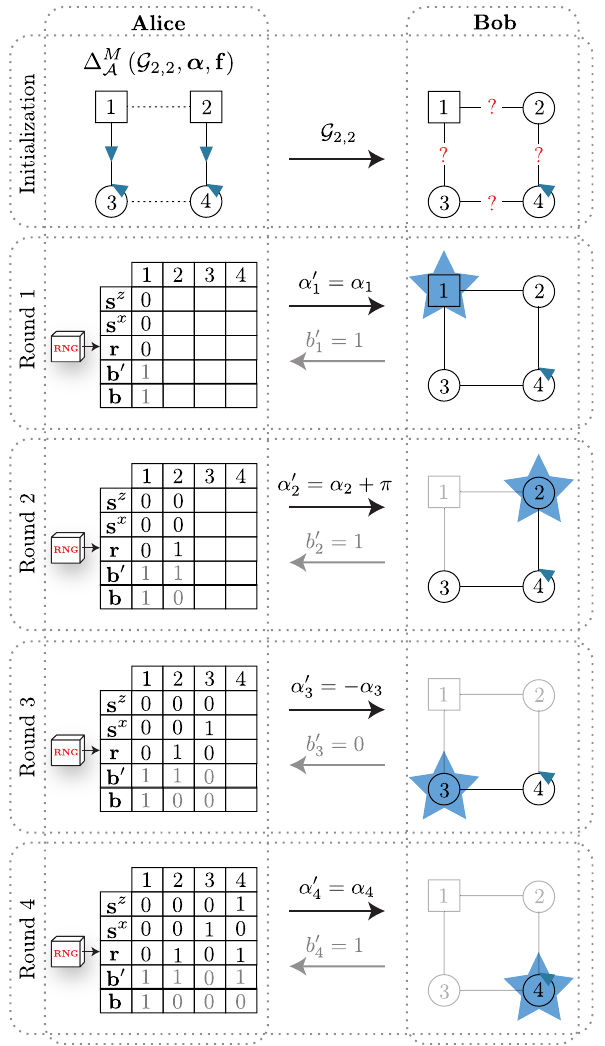
FIG. 6. Illustration of an exemplary run of Protocol 1. At the start of the protocol, Alice ’ s computation is expressed as a measurement pattern on a graph, in this case, G 2 . This is communicated to Bob, ; 2 who prepares the initial state. The computation then proceeds in rounds with Alice computing the relevant entries of s x and s z and, using these together with r , the measurement angle α 0 . The i i is communicated to Bob, who performs measurement angle α 0 i the measurement and returns the result to Alice as b 0 . From this, i ⊕ r as b 0 .Thisprocessisrepeateduntilallqubits Alicecomputes b i i i have been measured. At the end of the protocol, for any fixed transcriptofthecommunication(composedof α 0 and b 0 ),itisalways possible to find a choice for α consistent with the transcript for any choice of f . In other words, for any of the possible g-flow configurations shown in Fig. 5, Bob can find an α that would have ledto thetranscript herecorded, whichmeans anyofthoseg-flows is possible. This ambiguity is responsible for partially hiding Alice ’ s computation from